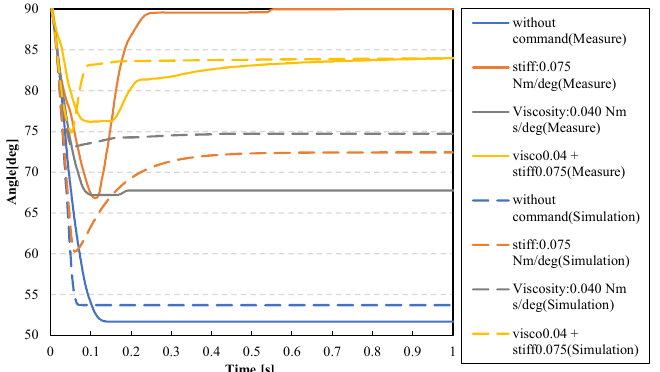
Figure 22. Simulation and measurement angle of impact force experiment results of angle.